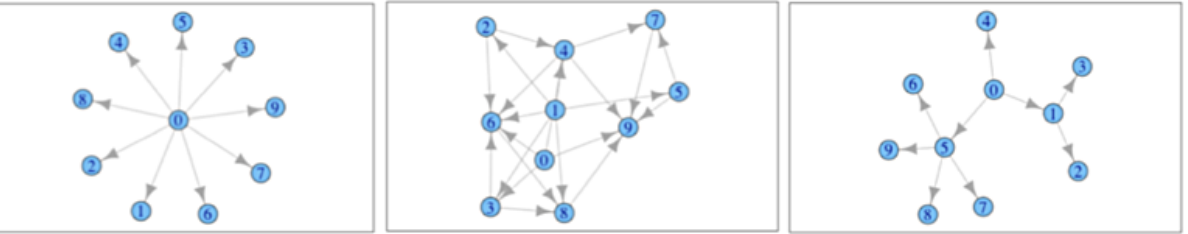
Figure 1. Network configurations - Star, Random, Small World (left to